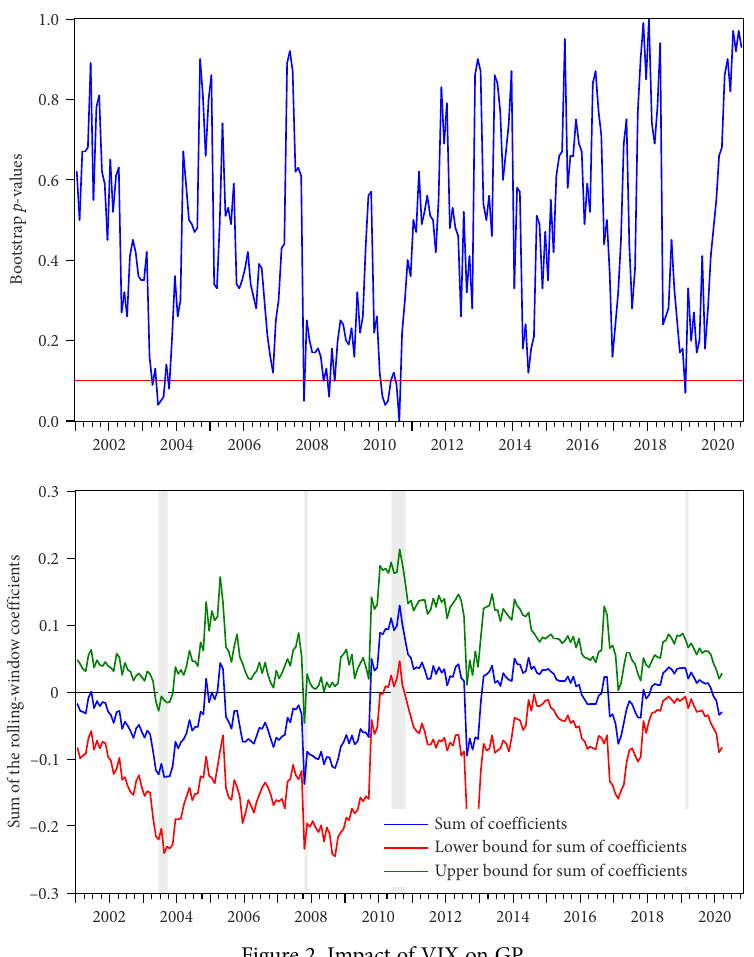
Figure 2. Impact of VIX on